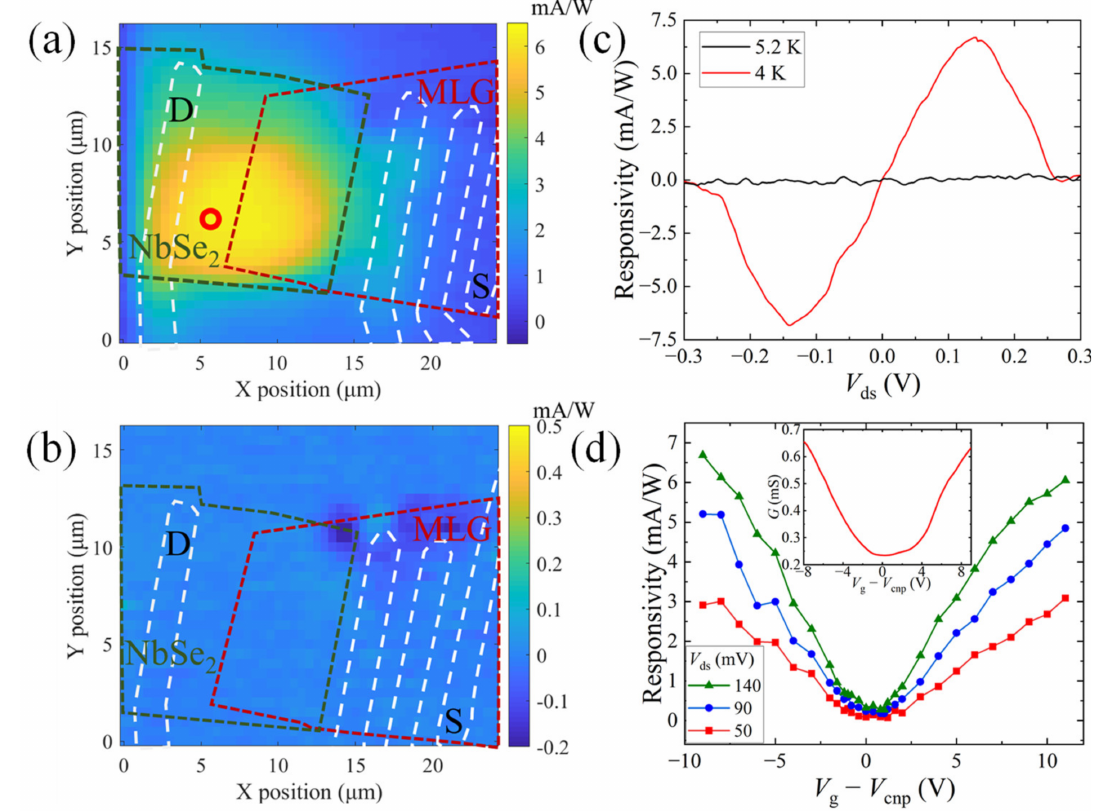
Figure 2. Photoresponse of the NbSe 2 -graphene heterojunction. ( a , b ) Spatial photoresponsivity map at T = 4.0 K ( a ) and 10.0 K ( b ). A dc bias voltage of V ds = 140 mV is applied between the S and D electrodes and V g − V cnp = − 9 V. The green/red/white dashed lines show the geometry of the NbSe 2 , MLG and the electrodes, respectively. The red circle in ( a ) corresponds to the position of the laser spot for the measurement in ( c , d ). ( c ) Photoresponsivity as a function of the bias voltage V ds at V g − V cnp = − 9 V above (black line) and below (red line) the superconducting transition temperature of the NbSe 2 . ( d ) Photoresponsivity as a function of the gate voltage V g − V cnp at selected bias voltages. The laser power is fixed at P = 20 µ W for ( a – d ). Inset: Gate-dependent two- probe conductance of the MLG in the